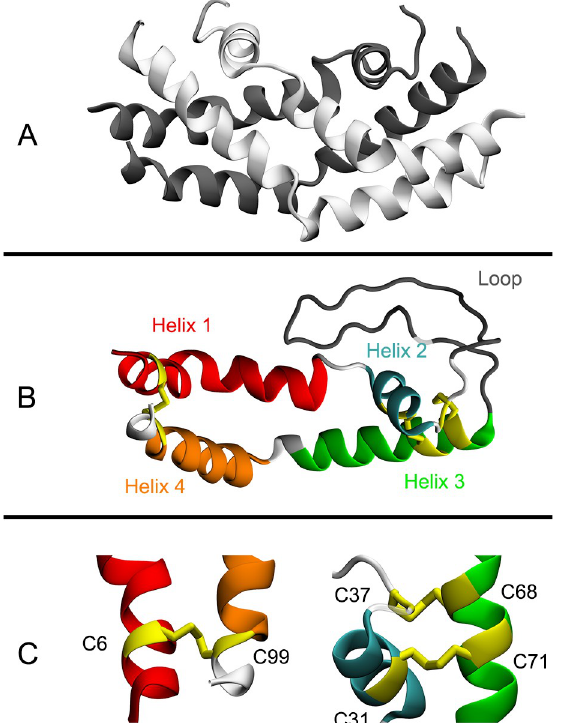
Fig 1. Structural units of the St PSI. A) St PSI in the “open dimer” conformation; separate monomers are different colors, and the loop portion has been omitted for clarity. B) The four helices and loop portion of a St PSI monomeric unit; each feature is color coded and all disulfide bonds are highlighted. C) Zoomed in view of the three disulfide bonds; helical elements are colored as per panel B. The initial structure for these renders is from the crystal structure of the St PSI (PDB ID: 3RFI)